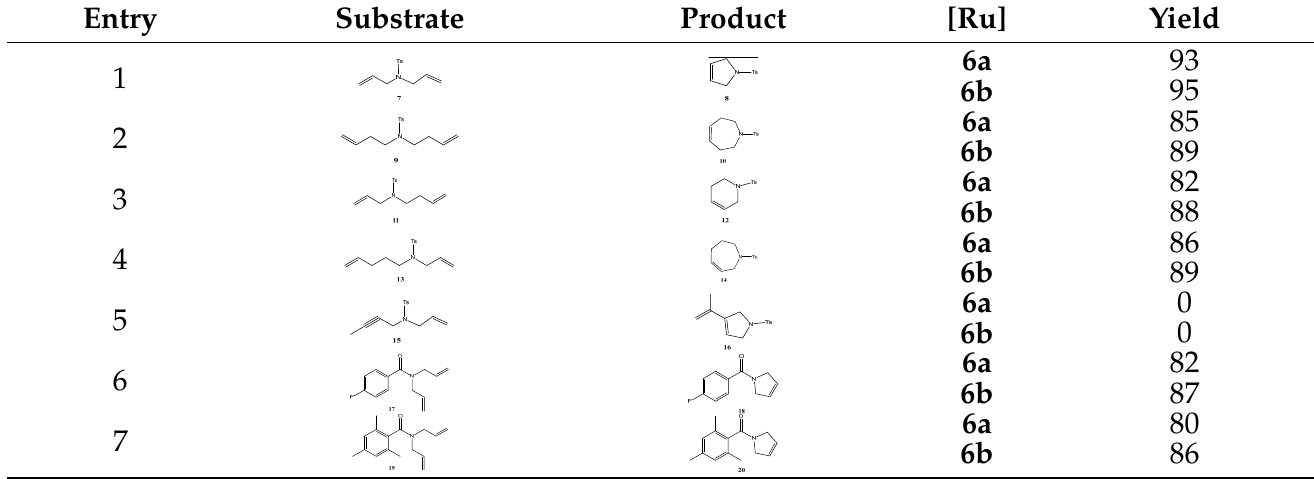
Table 2. Substrate scope of RCM reactions a .